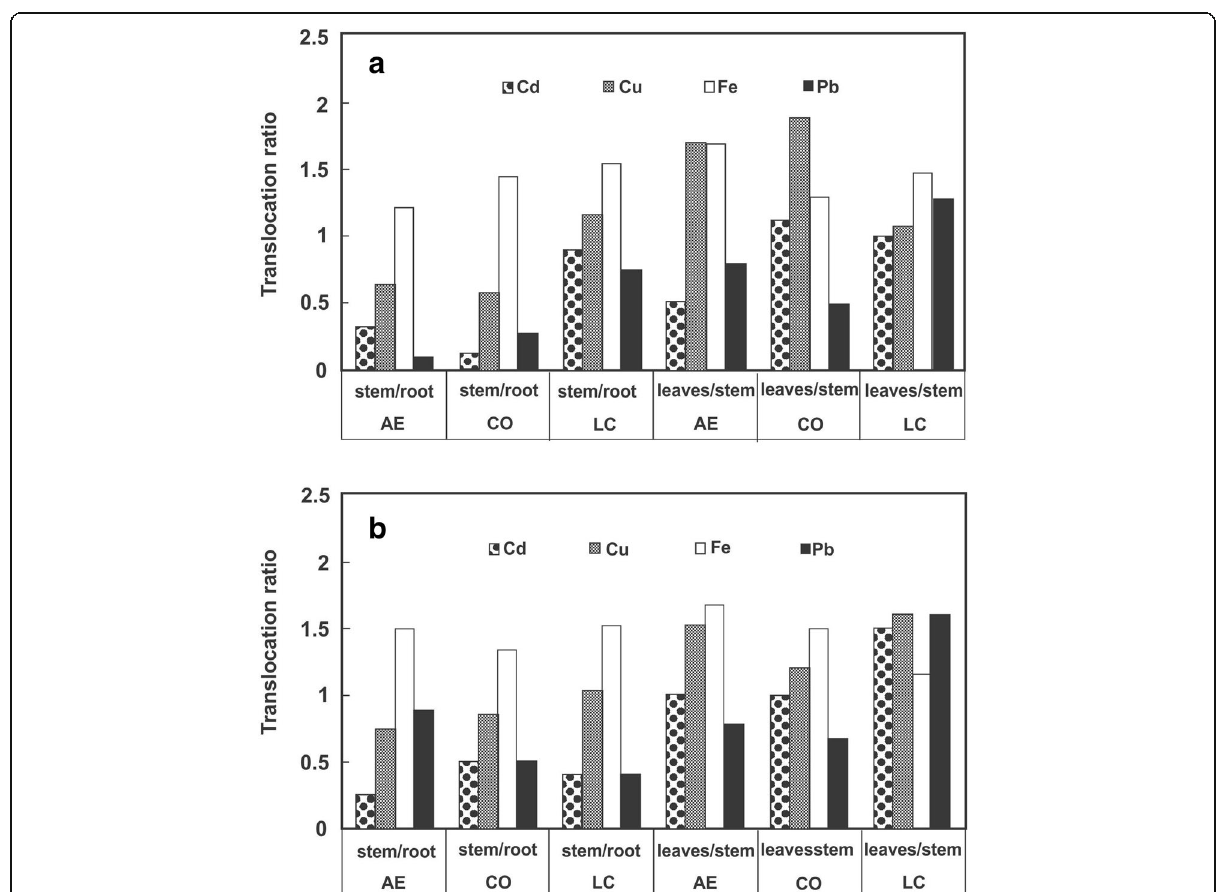
Fig. 4 Translocation ratios of metals from roots to stems and stems to leaves of Athyrium esculentum (AE), Chromolaena odorata (CO), and Lantana camara (LC) for a roadside sample and b control